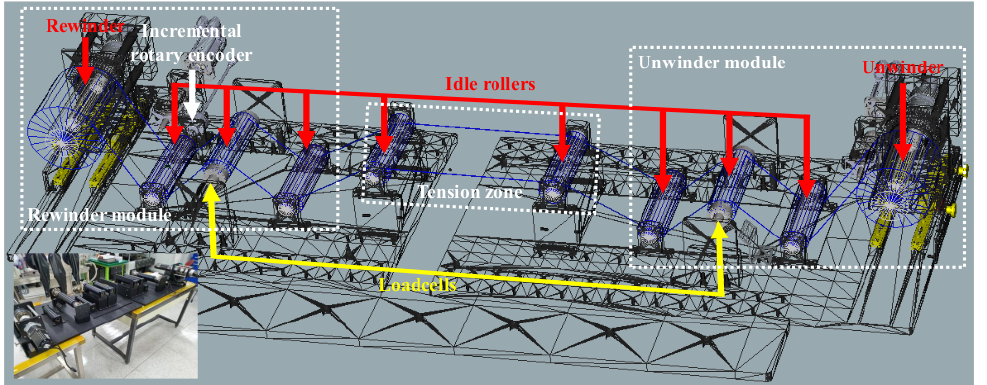
Figure 1. System structure of the two-actuator-based R2R system.